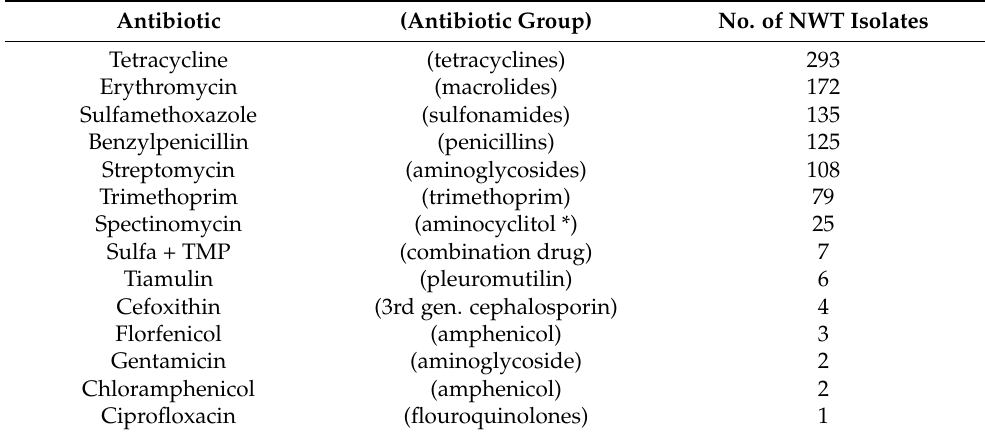
Table 8. Non-wildtypes (NWTs) of Staphylococcus delphini isolates from the weaning , growth , and breeding samplings in Denmark (n = 543). Antibiotic Tetracycline